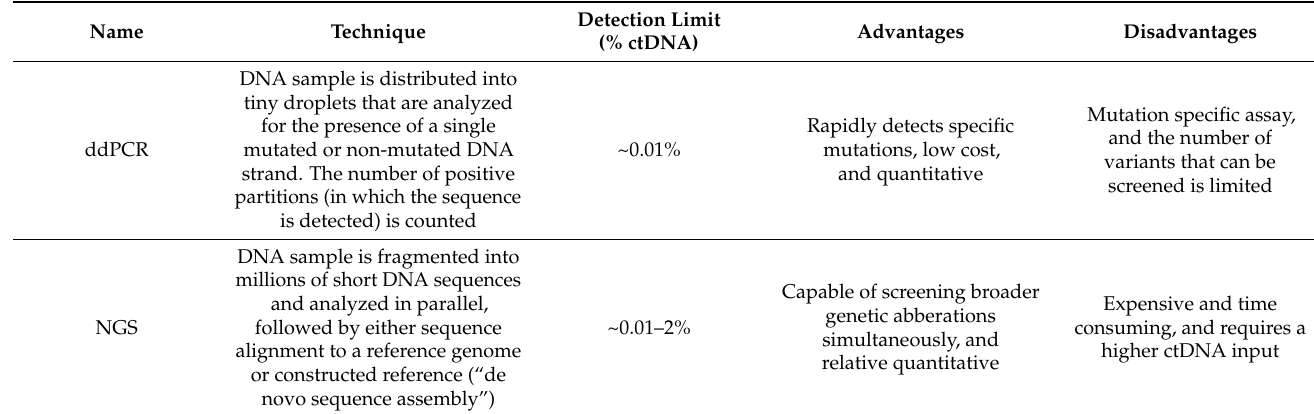
Table 1. Methods most frequently used for sarcoma ctDNA analysis. ddPCR: digital droplet PCR; CNA: copy number alteration; NGS: next generation sequencing